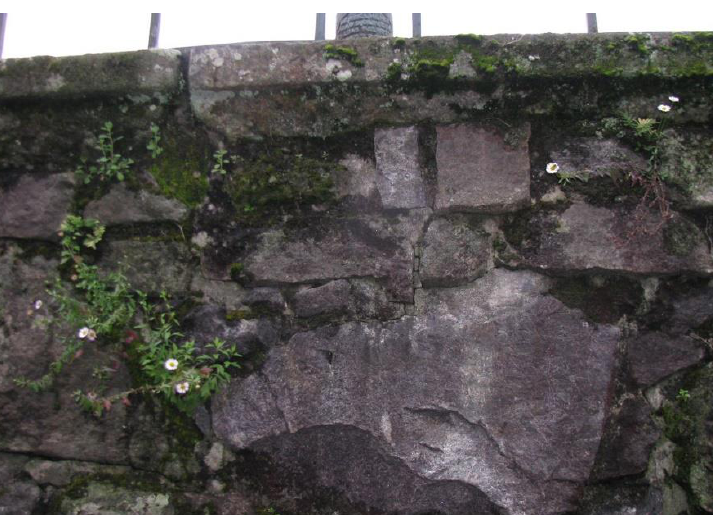
Figure 4. Illustrative image of relations between substrate and biological colonization with lichens and moss on the stones and plants in the joints between the wall stones.